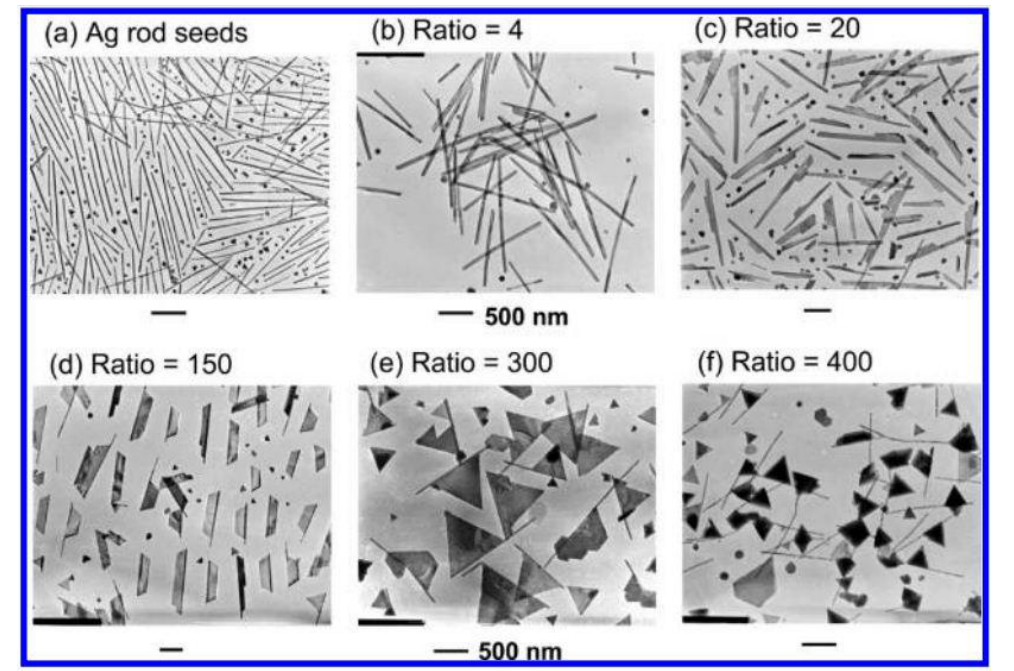
Figure 3. TEM images of Ag rod seeds and flag types of Ag nanostructures prepared in DMF at various [AgNO (2010) American Chemical